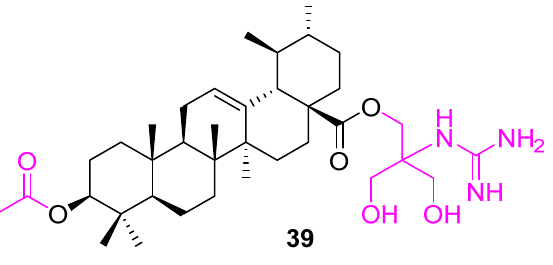
Figure 25. Structure of 39 .